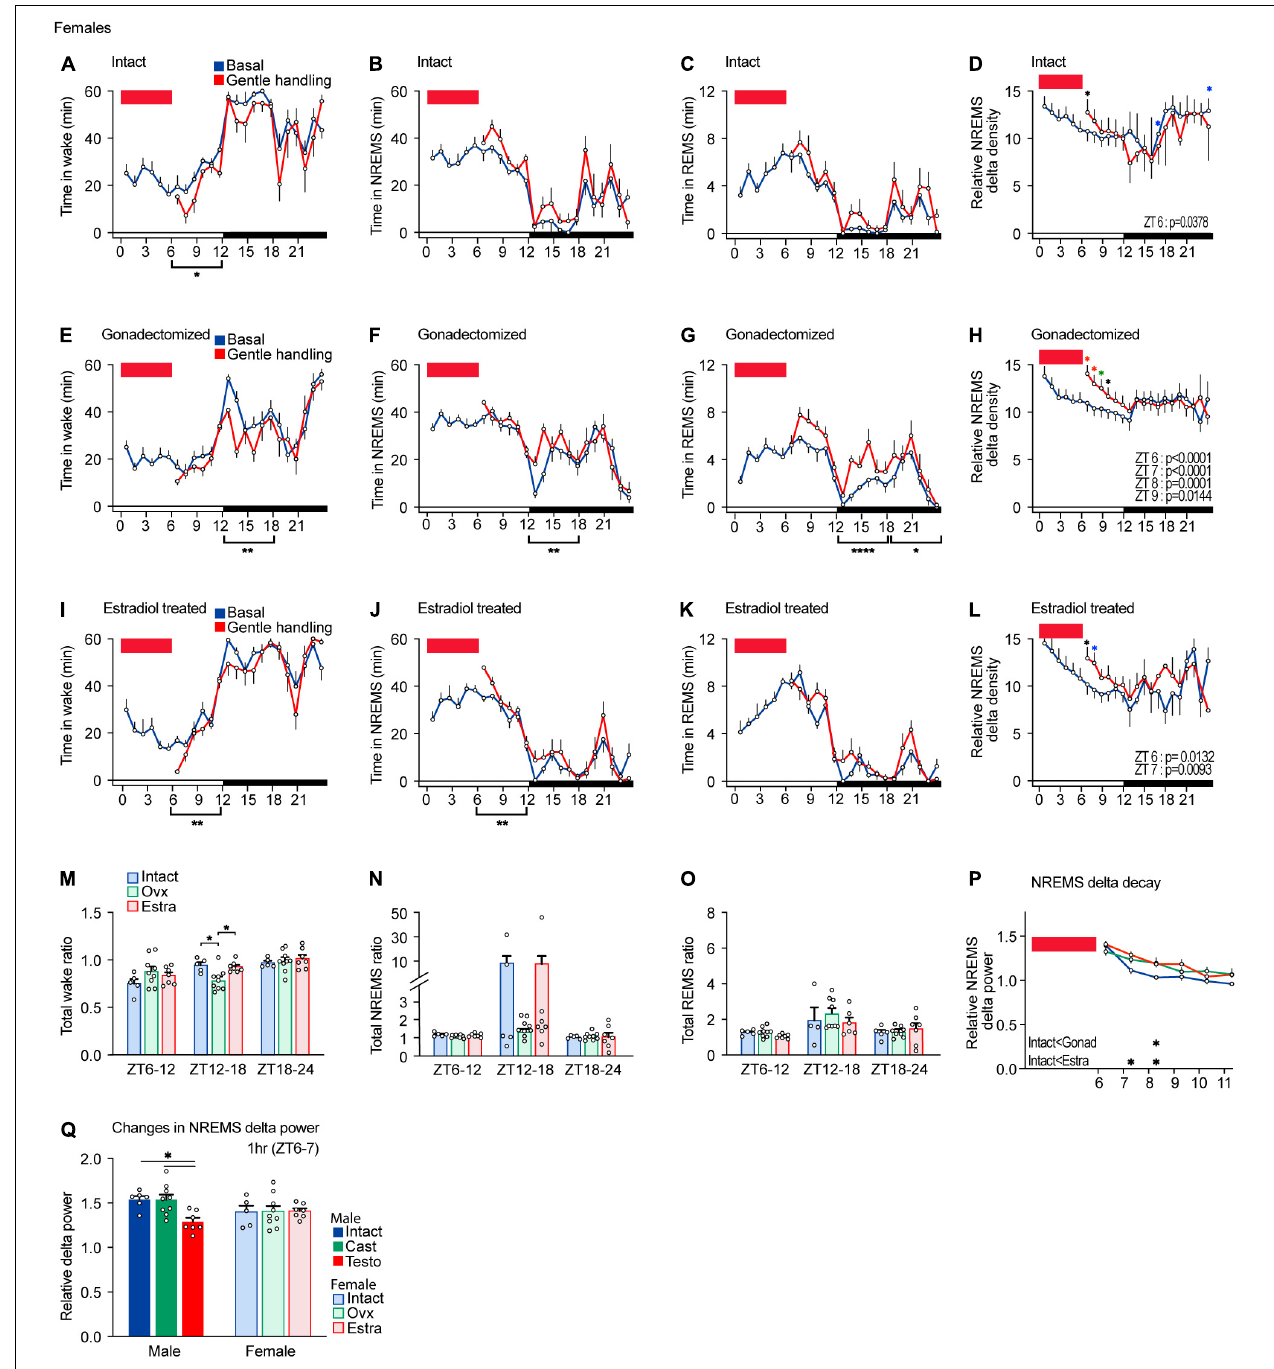
FIGURE 4 | Sleep/wake behavior of female mice after sleep deprivation by gentle handling. (A–D) Hourly wake time (A) , NREMS time (B) , REMS time (C) , and NREMS delta density (D) under the baseline condition and after 6-h sleep deprivation from ZT0 in intact female mice; five mice. Two-way ANOVA followed by Sidak’s test. (E–H) Hourly wake time (E) , NREMS time (F) , REMS time (G) , and NREMS delta density (H) under the baseline condition and after 6-h sleep deprivation from ZT0 in gonadectomized female mice; nine mice. Two-way ANOVA followed by Sidak’s test. (I–L) Hourly wake time (I) , NREMS time (J) , REMS time (K) , and NREMS delta density (L) under the baseline condition and after 6-h sleep deprivation from ZT0 in estradiol-supplemented gonadectomized female mice; seven mice. Two-way ANOVA followed by Sidak’s test. (M–O) Ratio of total awake time (M) , NREMS time (N) , and REMS (O) in 18 h to baseline condition after 6 h of sleep deprivation. Two-way ANOVA followed by Sidak’s test or Kruskal–Wallis test. (P) NREMS delta after sleep deprivation. Two-way ANOVA followed by Sidak’s test. (Q) NREMS delta power for 1 h after 6-h sleep deprivation normalized by the baseline condition. Red rectangles in the graphs indicate gentle handling from ZT0 to 6. Two-way ANOVA followed by Sidak’s test. * P < 0.05; ** P < 0.01. * P < 0.05 (black); * P < 0.01 (blue); * P < 0.001 (green); * P < 0.0001 (red).